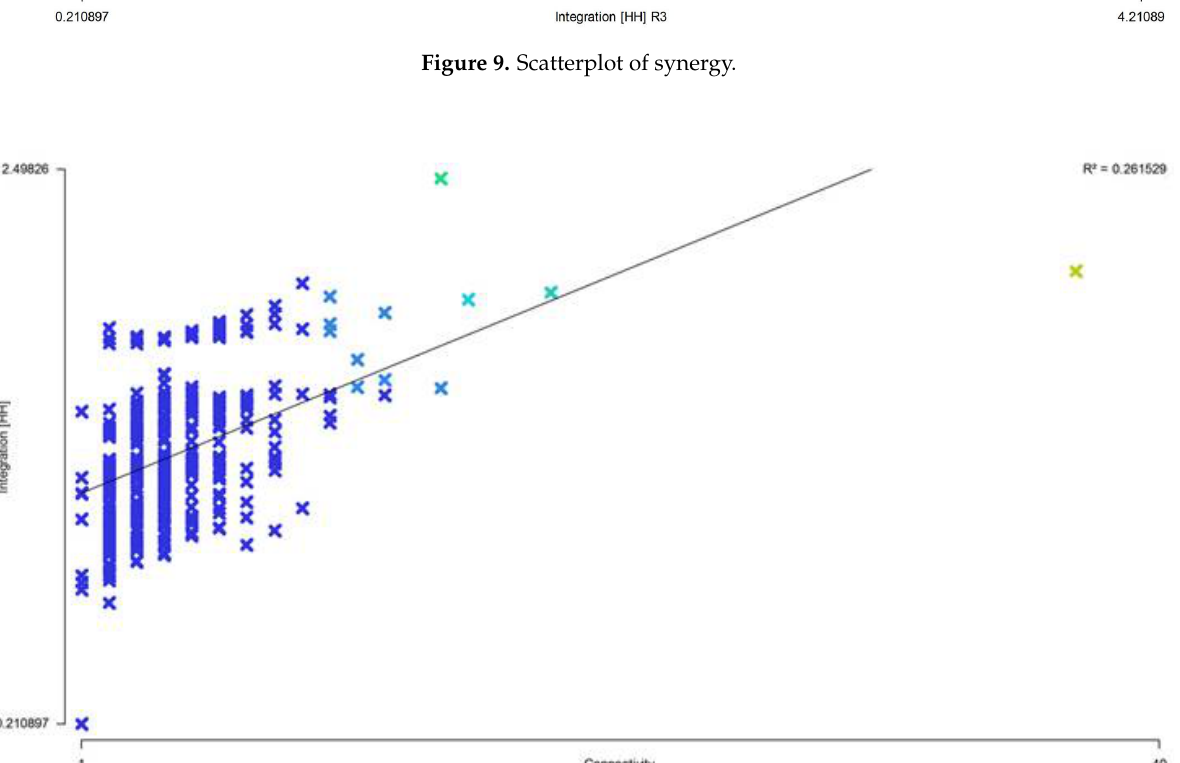
Figure 10. Scatterplot of intelligibility .